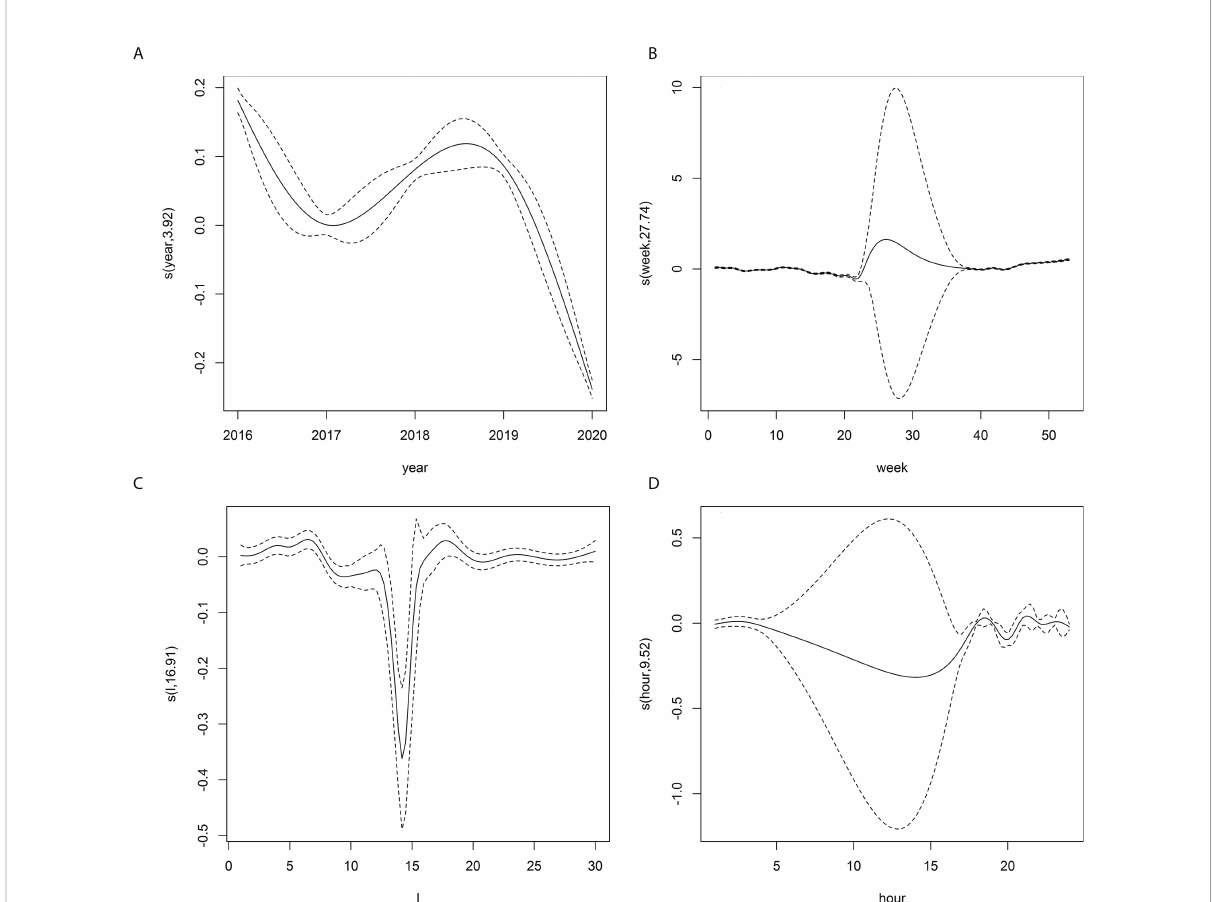
FIGURE 11 Analysis of the GAM model results of the in fl uence of time variables on CPUE. (A) year, (B) week, (C) l, (D) hour, the solid line is the in fl uence curve and the 95% con fi dence interval between the two dashed